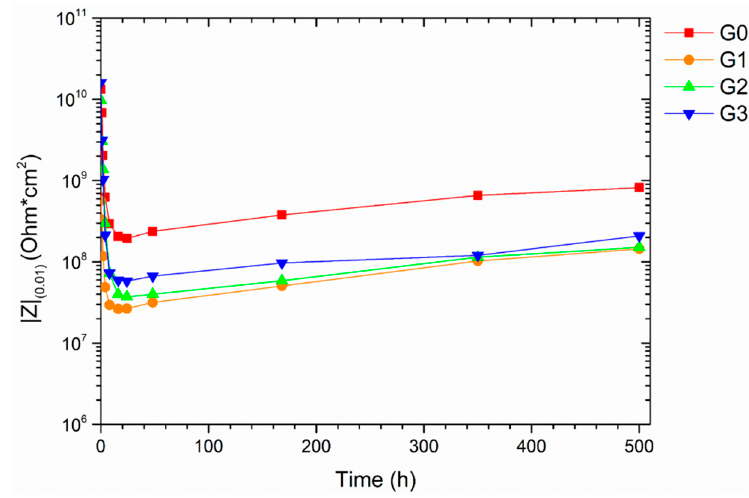
Figure 9. Bode impedance modulus |Z| (0.01) evolution with time.